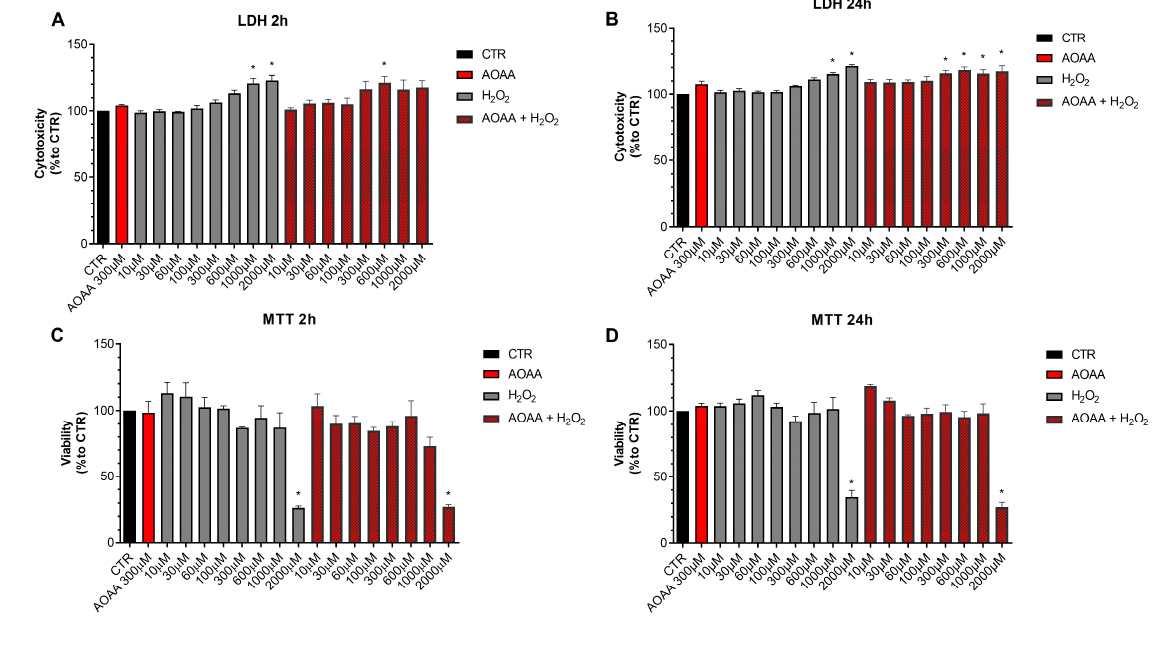
Figure 8. Effect of AOAA on the response to oxidative stress in EO771 cells. The CBS/CSE inhibitor (300 µM) did not affect oxidative stress induced cell death/loss of cell viability measured by LDH release ( A , B ) or MTT conversion ( C , D ) in the presence of H 2 O 2 challenge, as assessed at 2 or 24 h. N = 3 independent experiments ± SEM. * p < 0.01 shows significant differences compared to untreated control values.